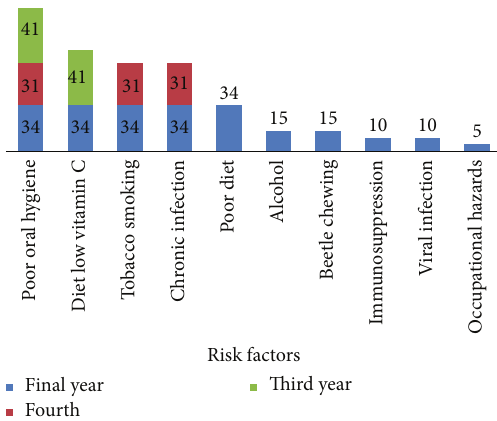
Figure 2: Dental students identifying risk factors for oral cancer ( 𝑁 = 106